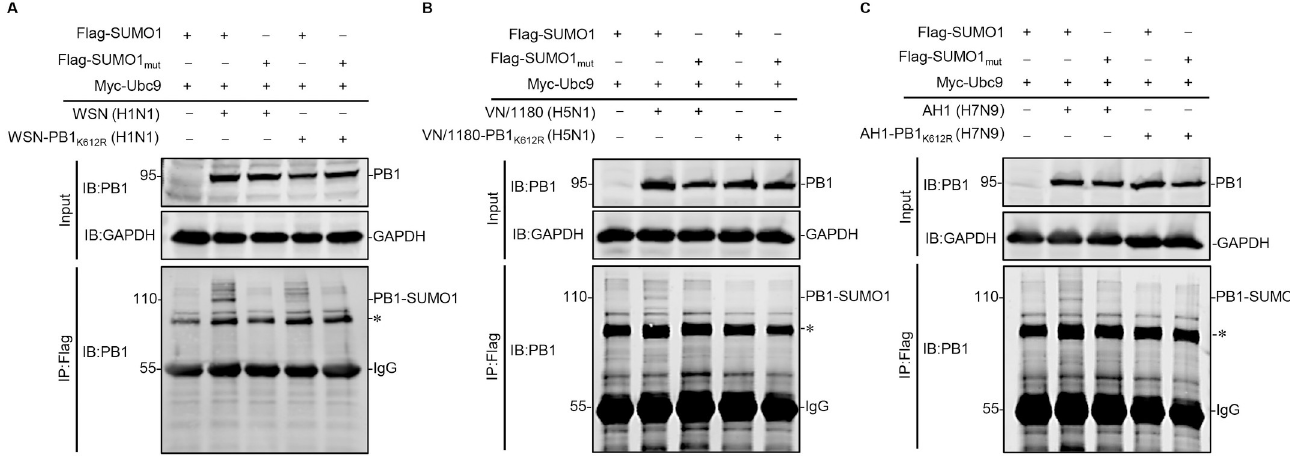
Fig 3. IAV PB1 is SUMOylated in infected cells. HEK293T cells were transfected with plasmids encoding Flag-tagged SUMO1 or SUMO1 mut , and Ubc9. At 24 h post-transfection, the cells were infected with WSN (H1N1) or WSN-PB1 K612R (H1N1) (A), VN/1180 (H5N1) or VN/1180-PB1 K612R (H5N1) (B), and AH/1 (H7N9) or AH/1-PB1 K612R (H7N9) (C) at an MOI of 2. Eighteen hours later, the cell lysates were immunoprecipitated with anti-Flag M2 agarose beads and western blotted with an anti-PB1 mAb. The asterisk indicates unknown protein. Data shown are representative of three independent